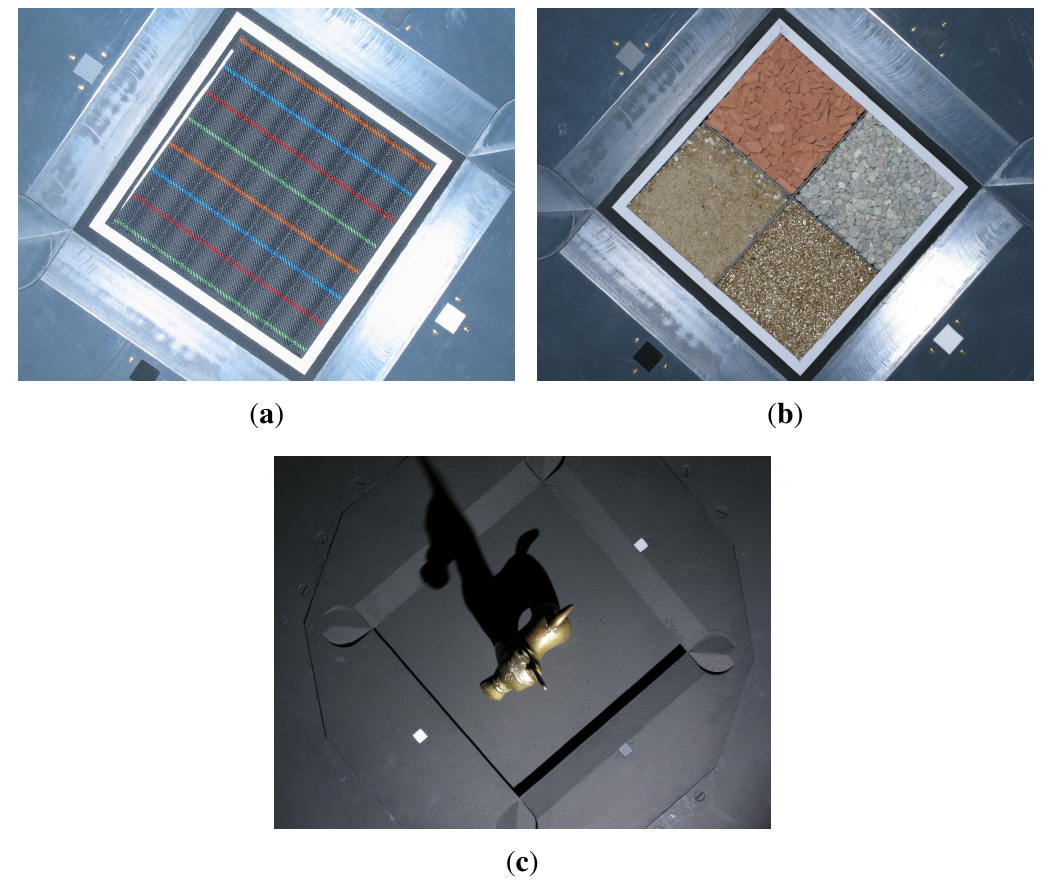
Pictures taken from the topmost camera of the Dome 1. (a) depicts a flat material sample taken with the Canon PowerShot A75 camera. (b) shows four granule material samples captured simultaneously and (c) a 3D object, both captured with the Canon PowerShot G9 camera. The material in (a) is used with courtesy of Volkswagen